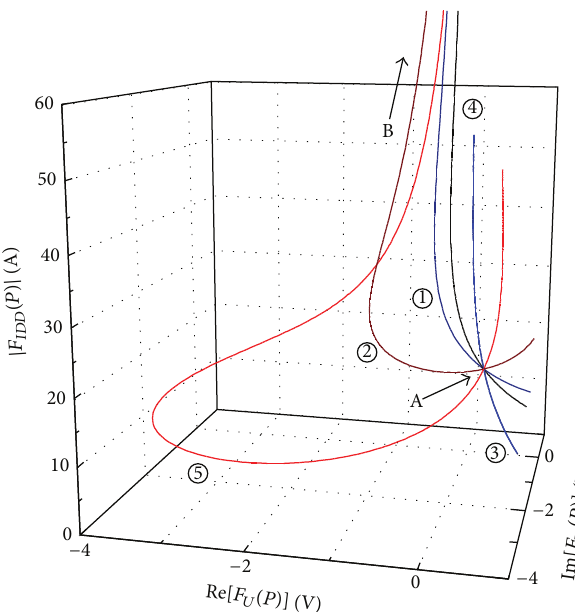
Figure 4: Family of fault loci in 3D complex place for the Sallen-Key filter. All 𝐹 𝑖 -loci converge in the fault free point A, while some 𝐹 𝑖 -loci have tendency to an infinity point B.